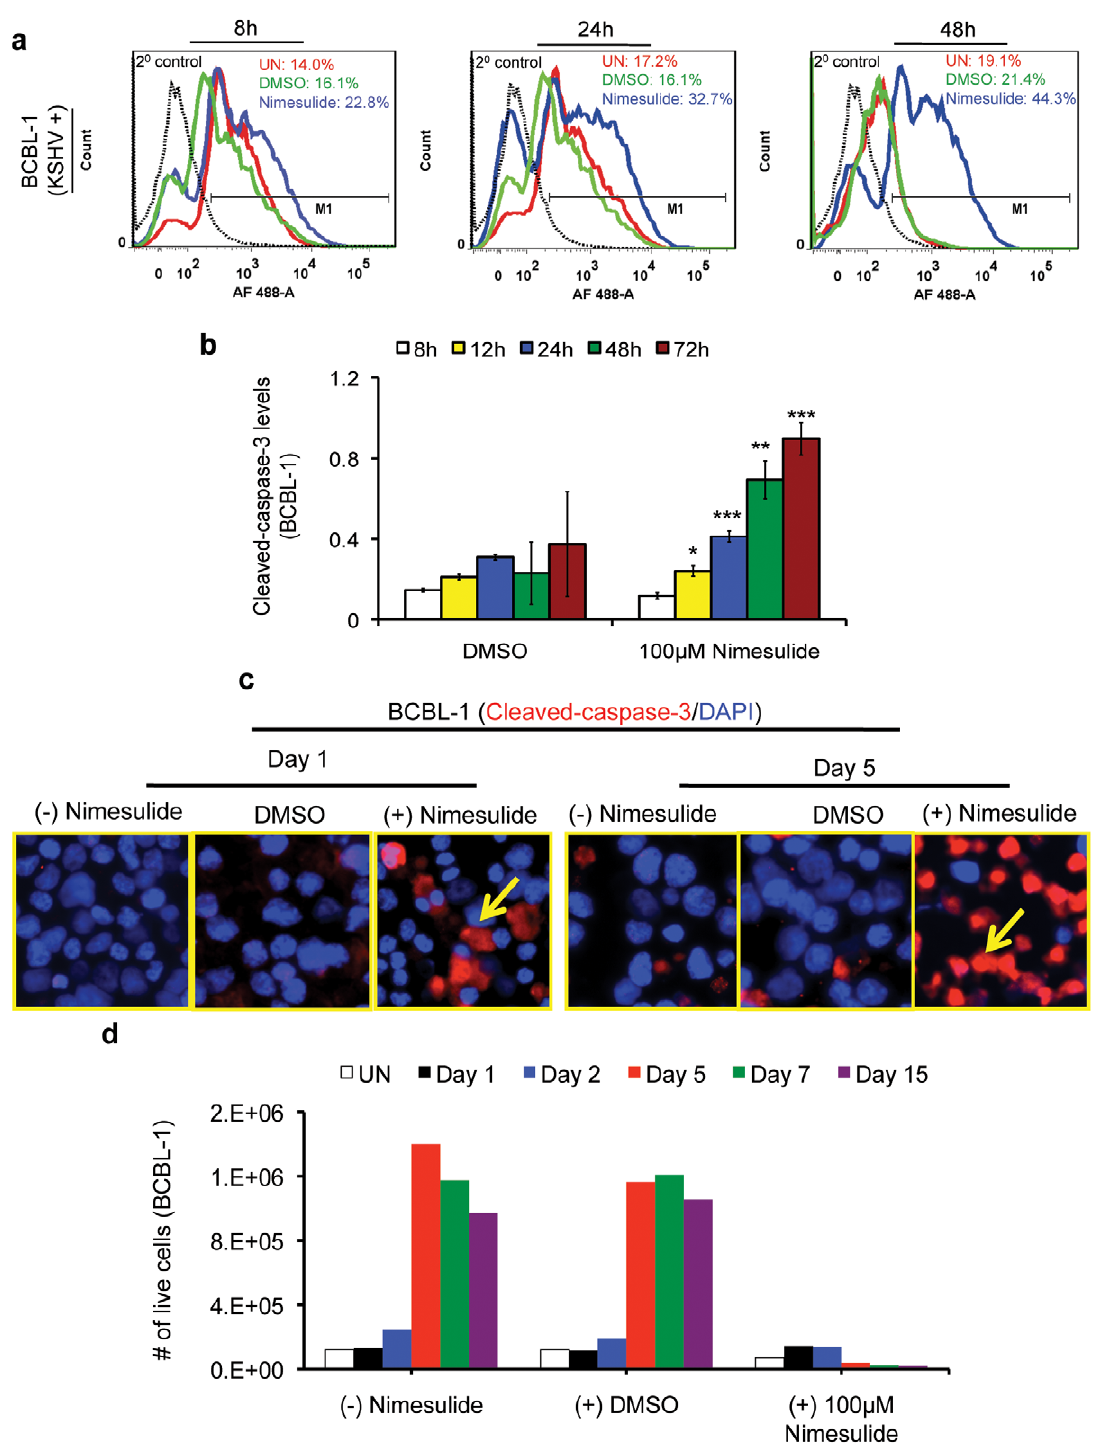
Figure 9. Effect of nimesulide on the apoptotic marker cleaved-caspase-3 in BCBL-1 and BJAB cells. ( a ) 5 6 10 5 BJAB and BCBL-1 cells were seeded with 100 m M nimesulide or DMSO or left untreated,. Samples were collected at 8 h, 24 h, and 48 h to examine the levels of the apoptotic marker cleaved-caspase 3 by FACS. The cells were neither replenished with fresh media nor supplemented with the nimesulide. Expression of cleaved caspase-3 is shown as compared to secondary alone control, which is shown in black (dotted) histogram. ( b ) The effect of nimesulide on cleaved-caspase-3 levels was measured by a more sensitive colorimetry based apoptosis assay as well at identical conditions as Fig. 9a at 8 h, 12 h, 24 h, and 72 h post-treatment with nimesulide. ( c ) In parallel experiments, BCBL-1 cells were collected at 24 h and day 5 after drug supplementation at days 3 and 4 to determine the levels of cleaved-caspase 3 by immunofluorescence for nimesulide and DMSO treatments, and for cells left untreated. ( d ) 1 6 10 5 BCBL-1 cells were seeded with 100 m M nimesulide and samples were collected at days 1, 2, 5, 7, and 15 to measure the number of live cells. 100 m M nimesulide was supplemented at days 3 and 4. The drug was removed by washing with PBS at day 7 and cells were replenished with fresh media. ( a–d ) The data represents four independent experiments. (*) p , 0.001, (**) p , 0.00001), (***) p , 0.000001).